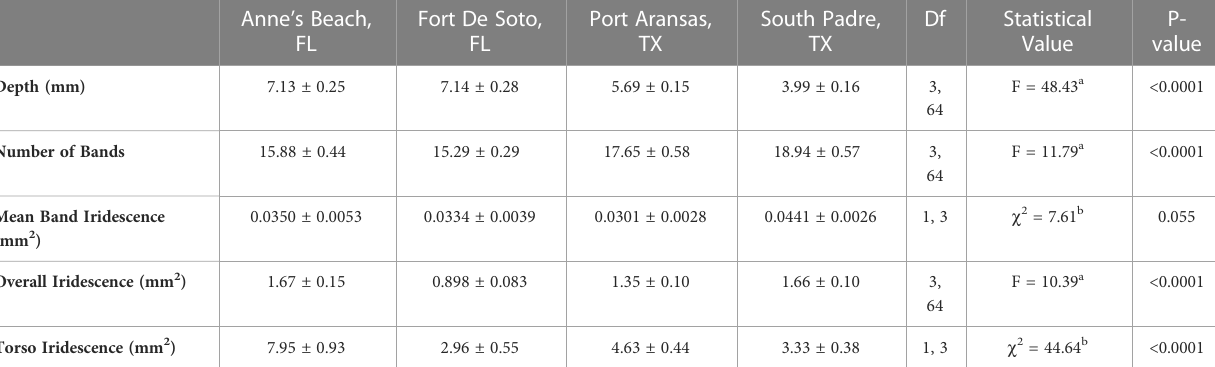
TABLE 1 Summary of morphometrics (mean ± S.E.) including body depth, number of bands, mean band iridescence, overall iridescence, and torso iridescence for female S. scovelli across the four geographic locations and results of statistical analyses